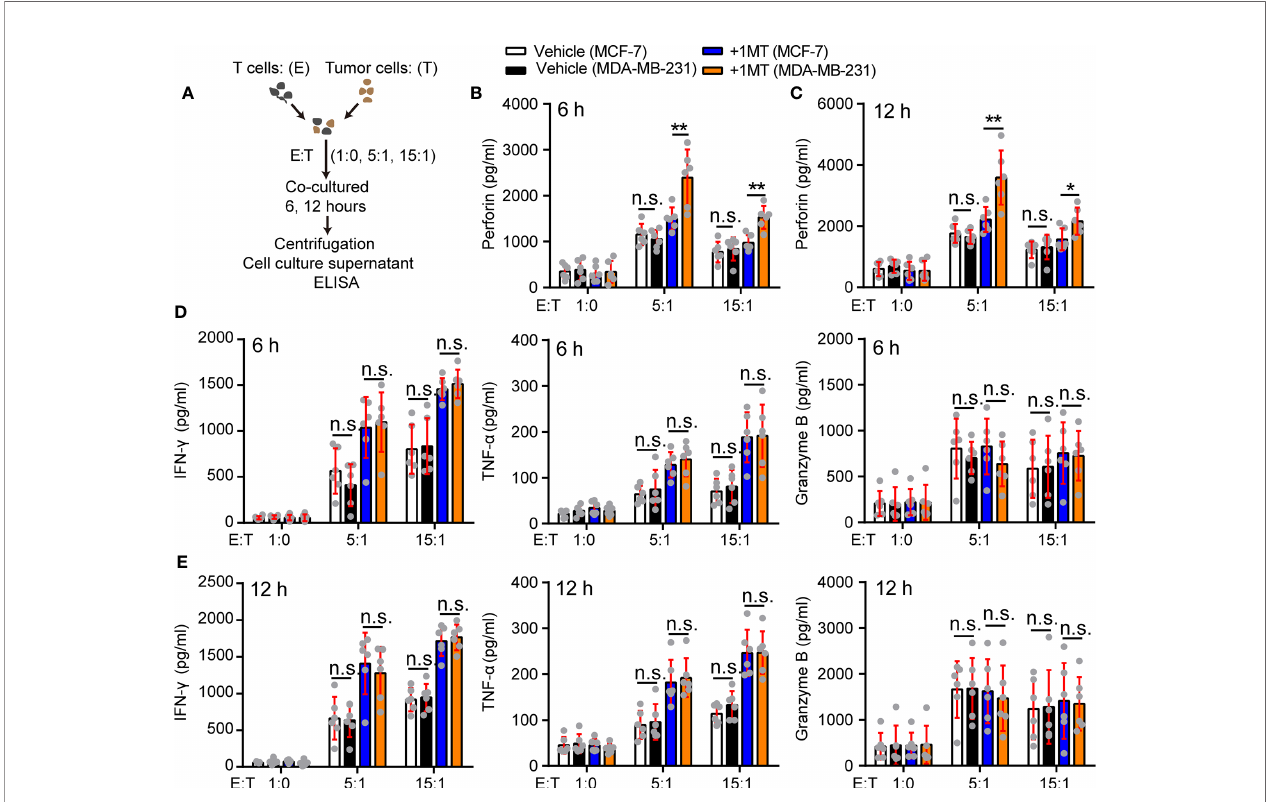
FIGURE 5 | Treatment with 1-MT and MDA-MB-231 cells enhanced perforin production of V g 9V d 2 T cells. (A) Experimental approach. (B – E) The levels of cytokines, released by V g 9V d 2 T cells, were measured by ELISA after V g 9V d 2 T cells from healthy donors were incubated with MCF-7 or MDA-MB-231 cells for 6 or 12 hours in the presence or absence of 1-MT (500 m M) ( n =6). Data represent mean ± SD; unpaired Student ’ s t -test (B – E) . Signi fi cance was set to P < 0.05 and represented as * P < 0.05, ** P < 0.01, *** P < 0.001, and **** P < 0.0001, n.s. , not signi fi